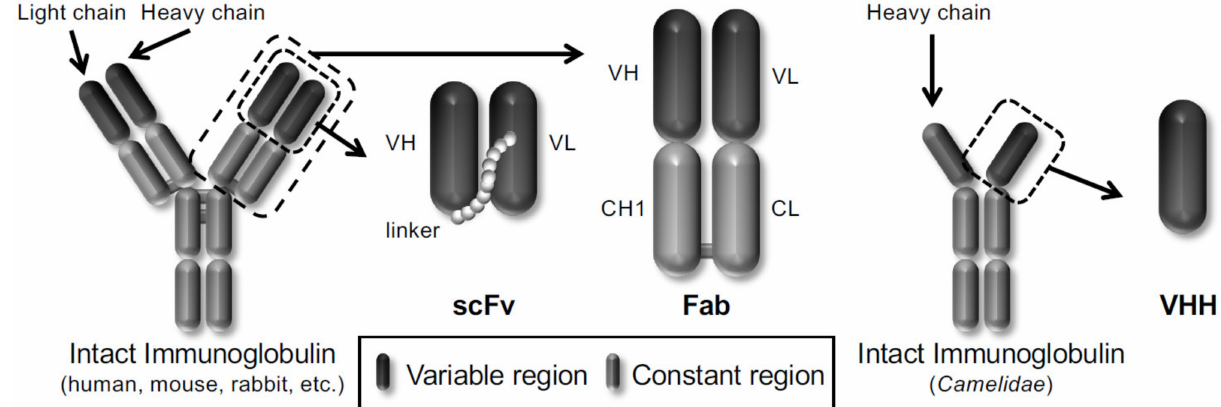
Figure 1. Schematic representation of different types of antibody formats displayed on the